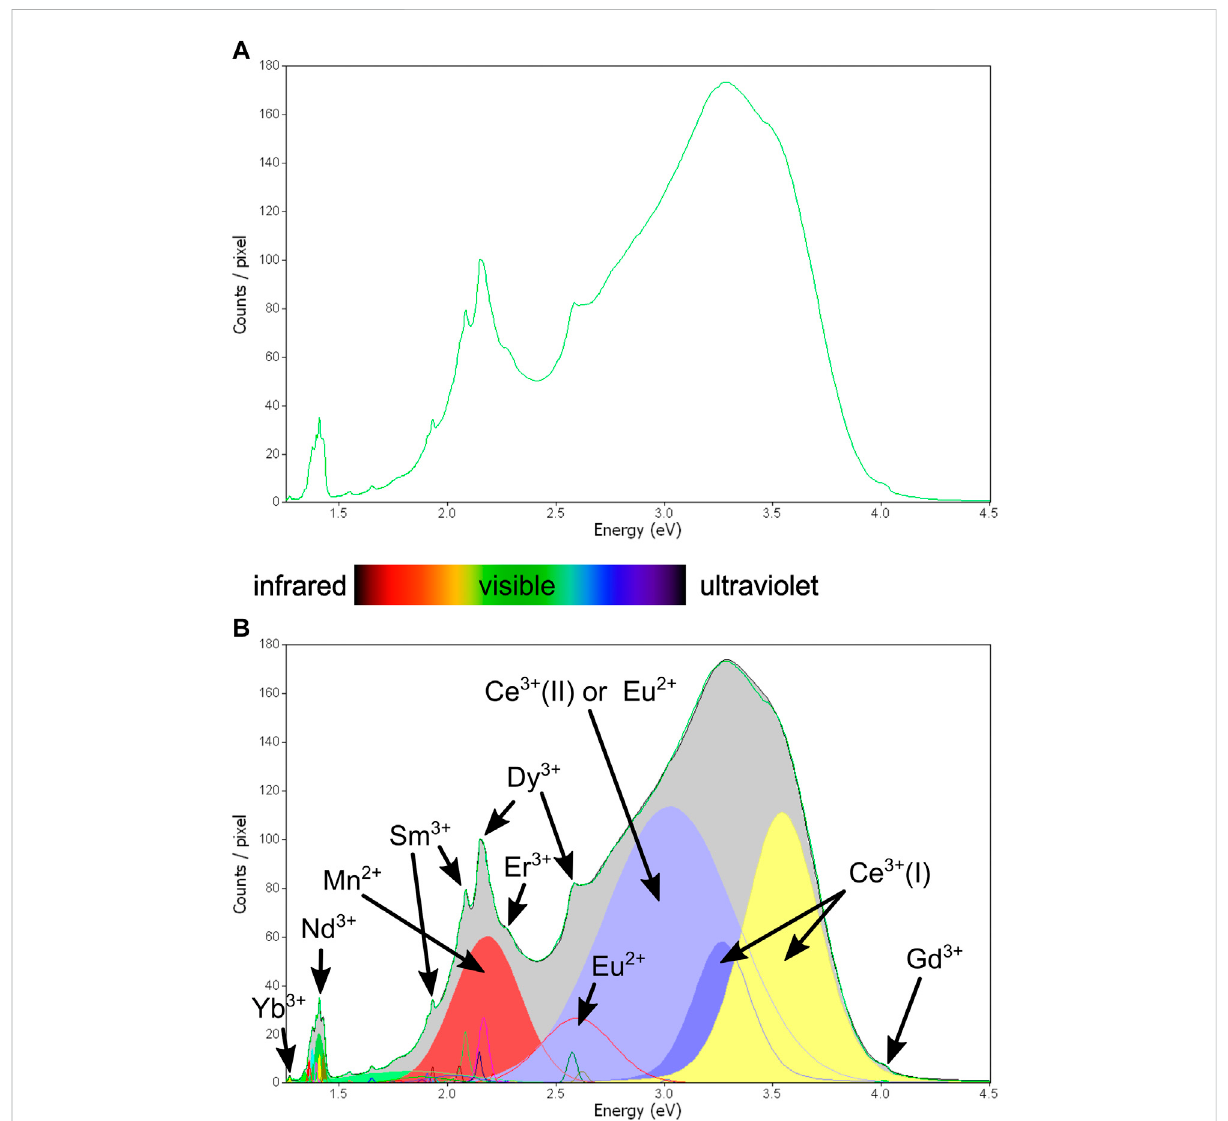
FIGURE 4 Example for peak fi tting of the hyperspectral CL data. Green line: average spectrum of all apatite pixels combined for sample MMA2-122.75. Black line: sum of all fi tted peaks. Some fi tted peaks match literature data well and can be identi fi ed with high con fi dence (Nd 3+ , Dy 3+ , Sm 3+ , Mn 2+ ), others where elements only have a single small peak within the spectral range are less certain (Er 3+ , Gd 3+ ) and fi tting. Some additional peaks were identi fi ed without match in the literature, e.g., see the broad peak at around 2.6